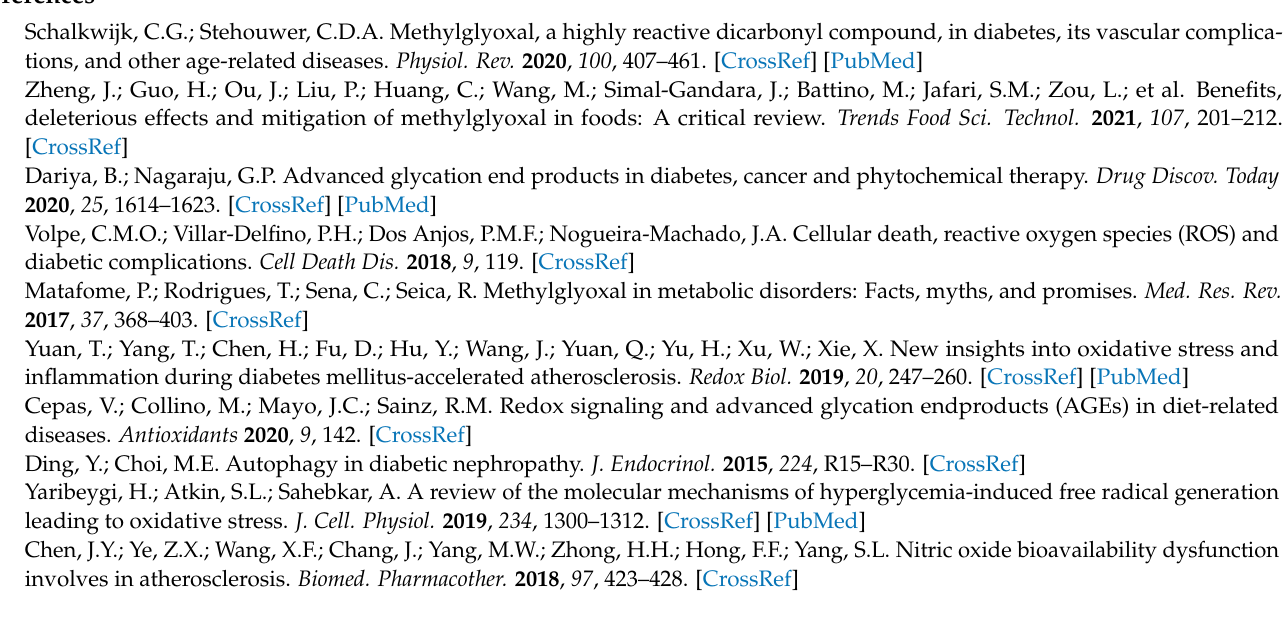
Figure S2: Original image of Western blot band intensities in Figure 6; Figure S3: Original image of Western blot band intensities in Figure 7; Figure S4: Original image of Western blot band intensities in Figure